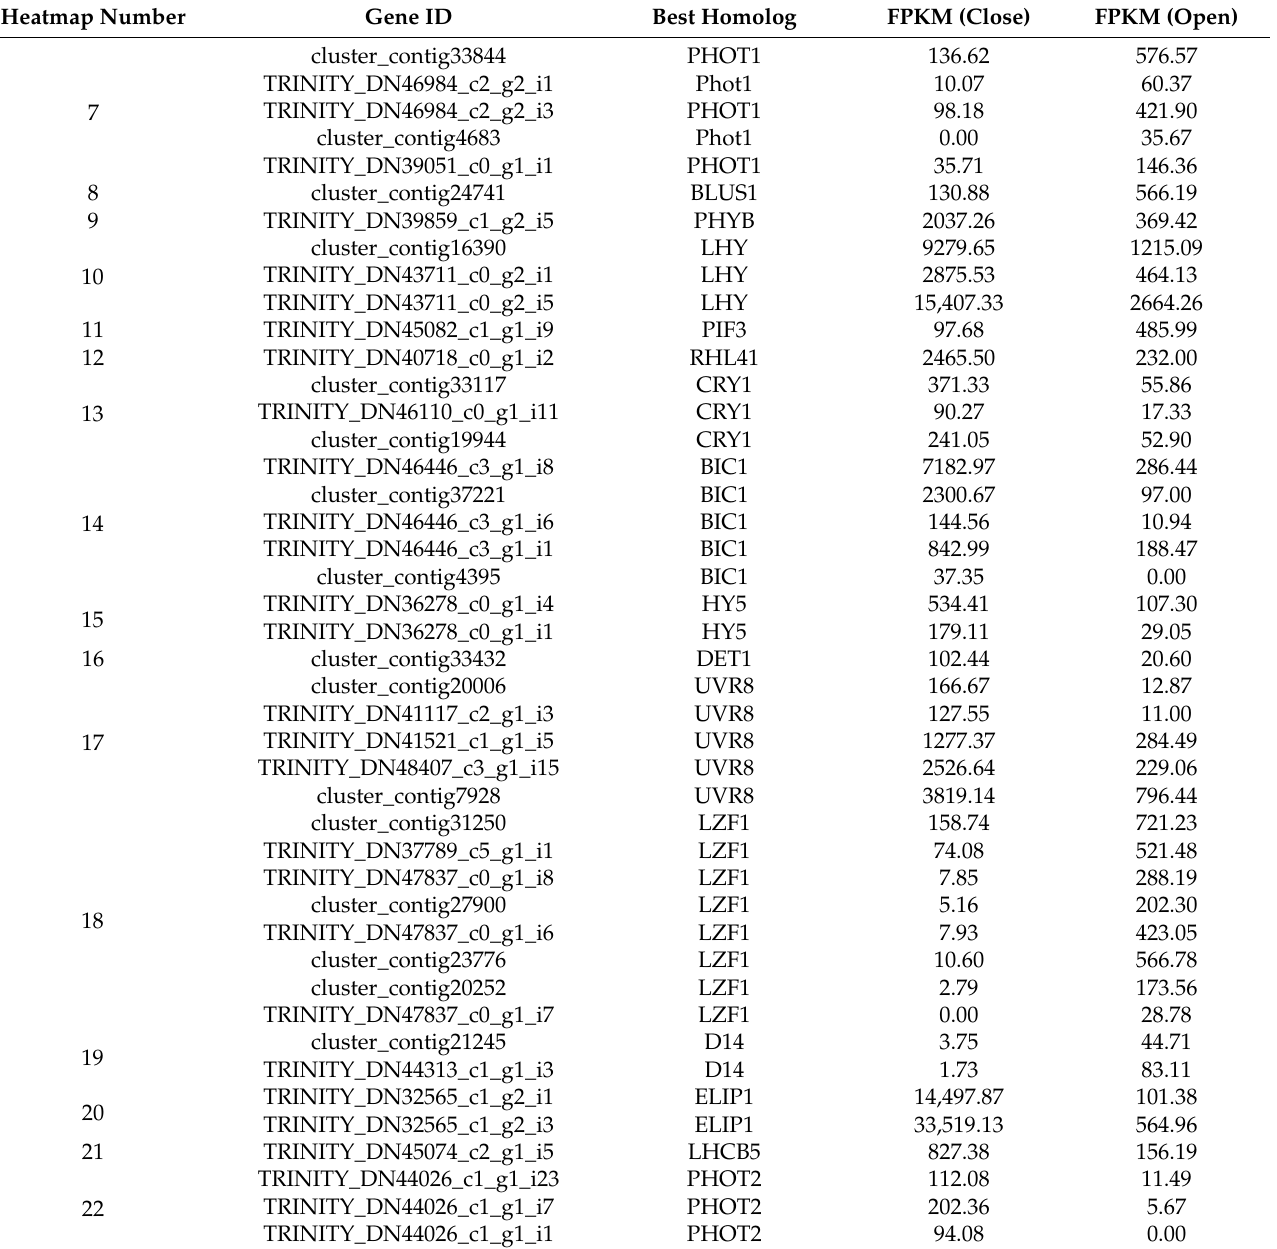
Table 2. Expression levels of light-signal-related genes (corresponding to Figure